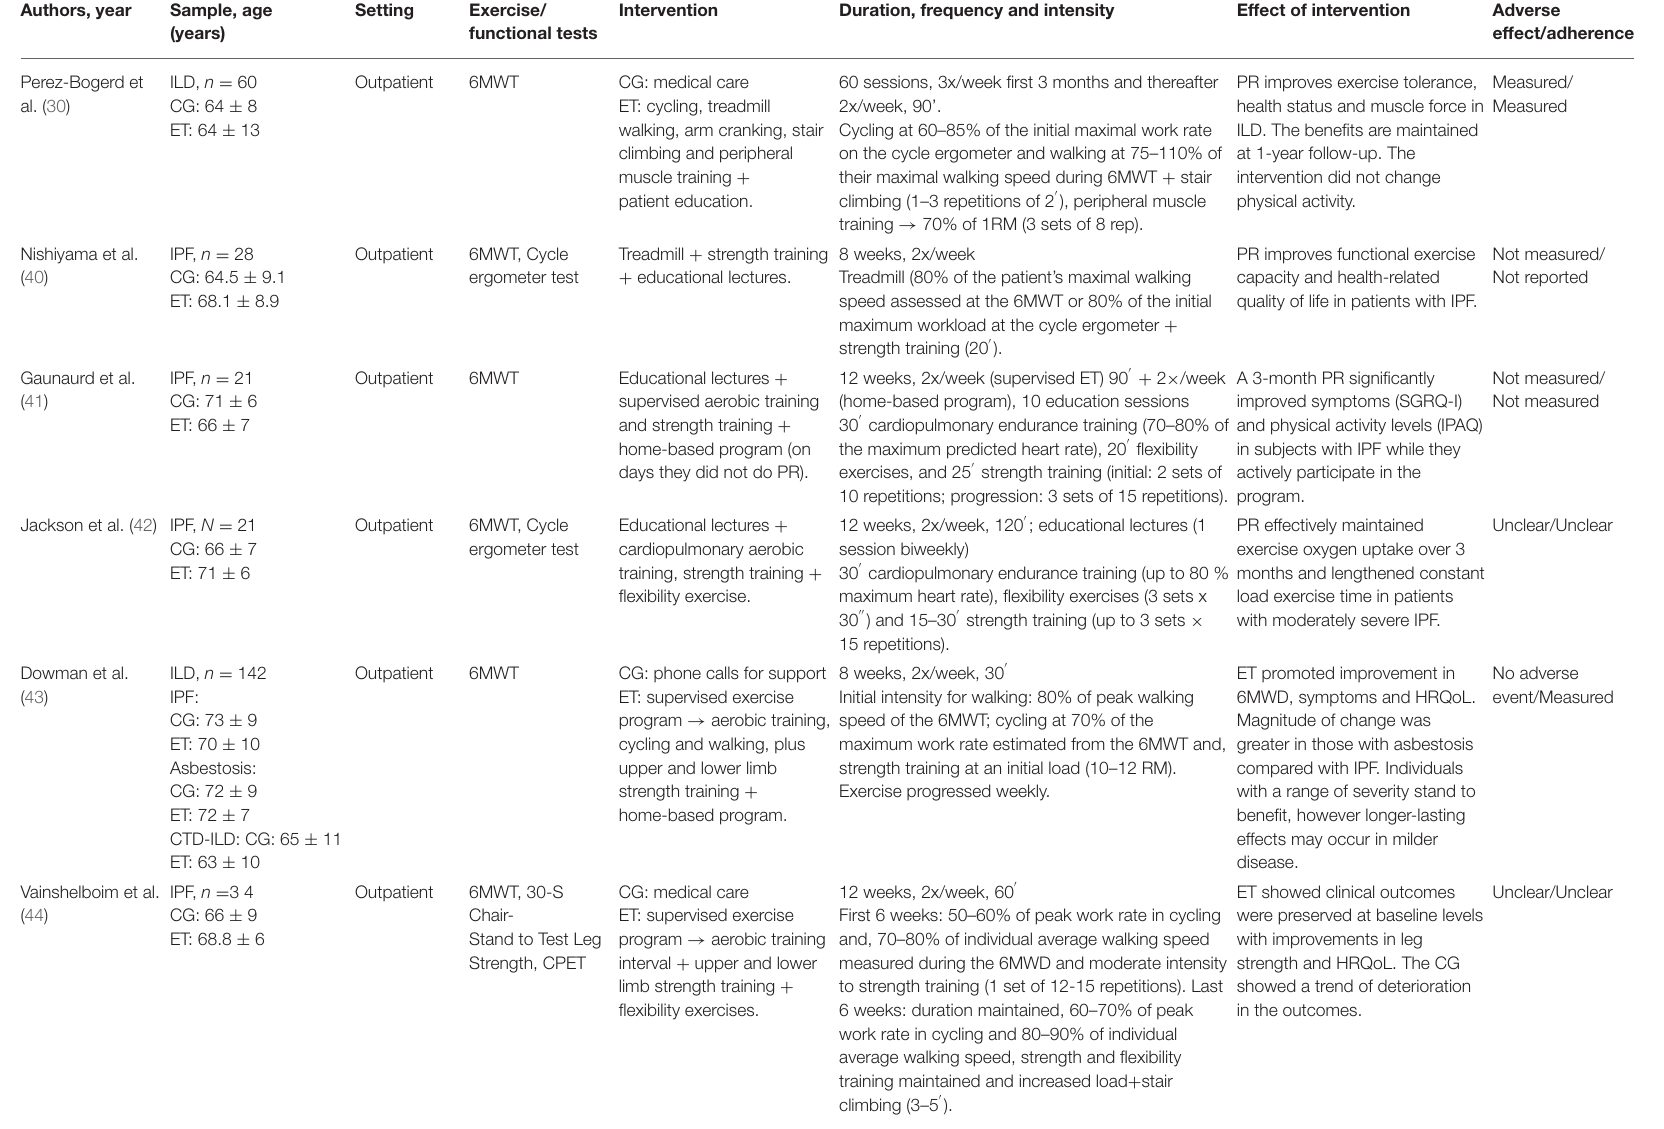
TABLE 1 | Randomized controlled trials involving exercise-based pulmonary rehabilitation in patients with interstitial lung